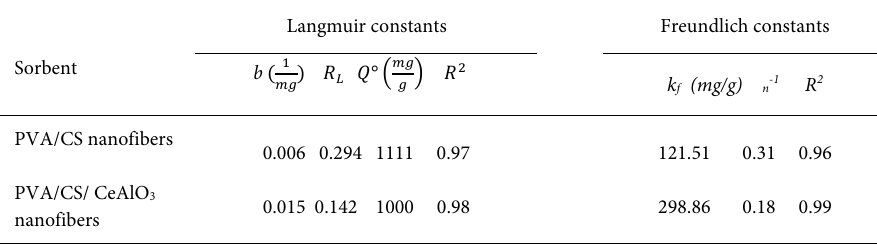
Table 2. sorption isotherm parameters for the MB removal by different sorbents